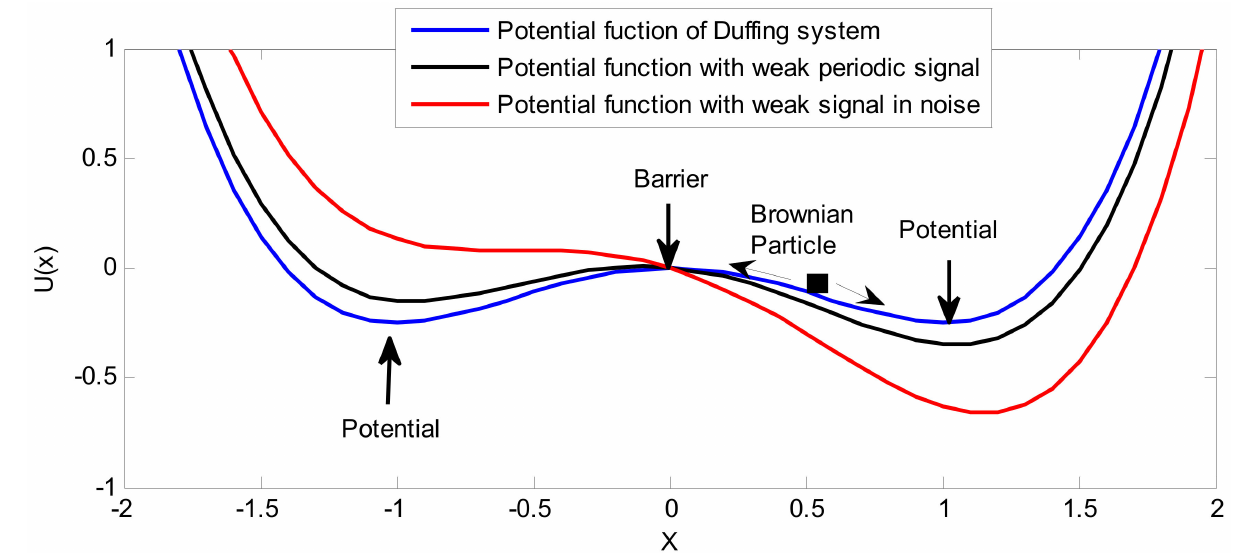
Figure 1. SR mechanism of the second-order Duffing